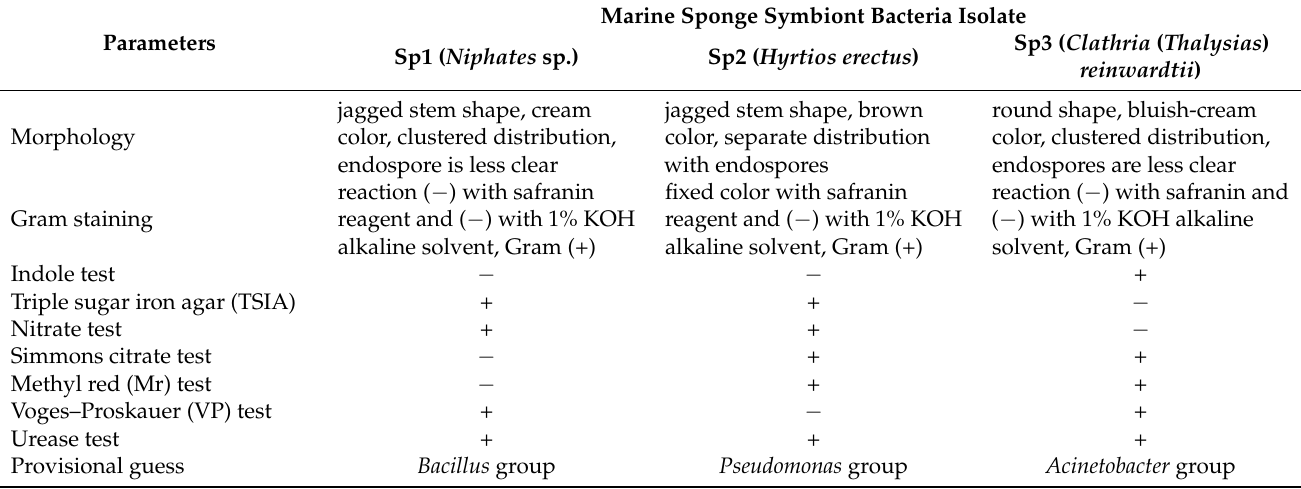
Table 2. Phenotypic characteristics of marine sponge symbiont bacterial